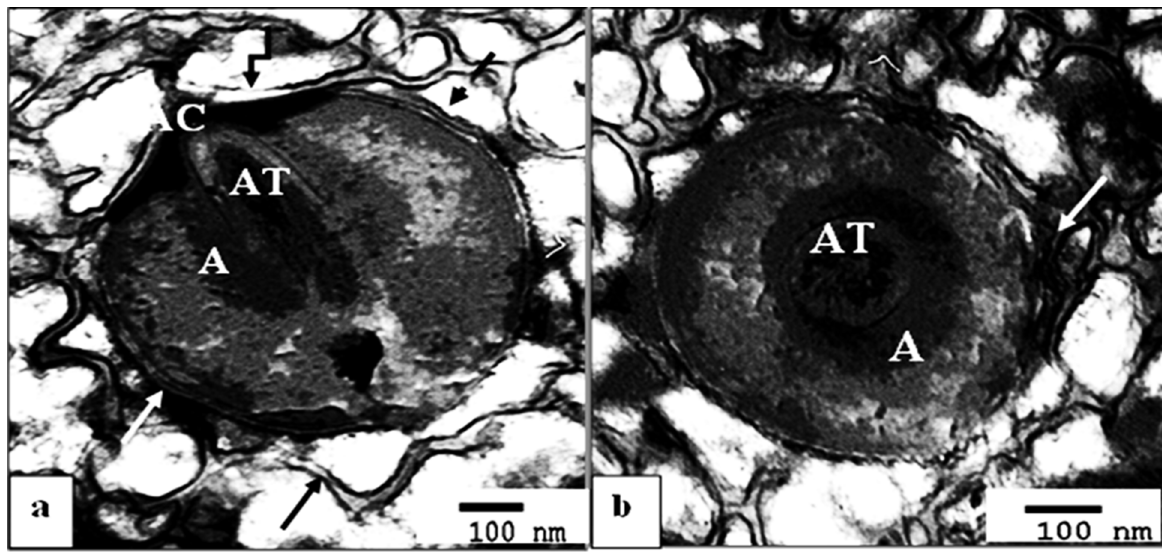
Figure 6. Spermatozoa with apical cap (AC), acrosomal membrane (dashed arrow), acrosome (A), acrosomal tubule (AT), lamellae (white arrow), operculum (Elbow arrow), and cell boundaries (black-arrow) ( a ). Spermatophore has spermatozoa with acrosomal tubule (AT), acrosomal membrane (black arrow), acrosome (A), and cell boundaries (white arrows) ( b ).